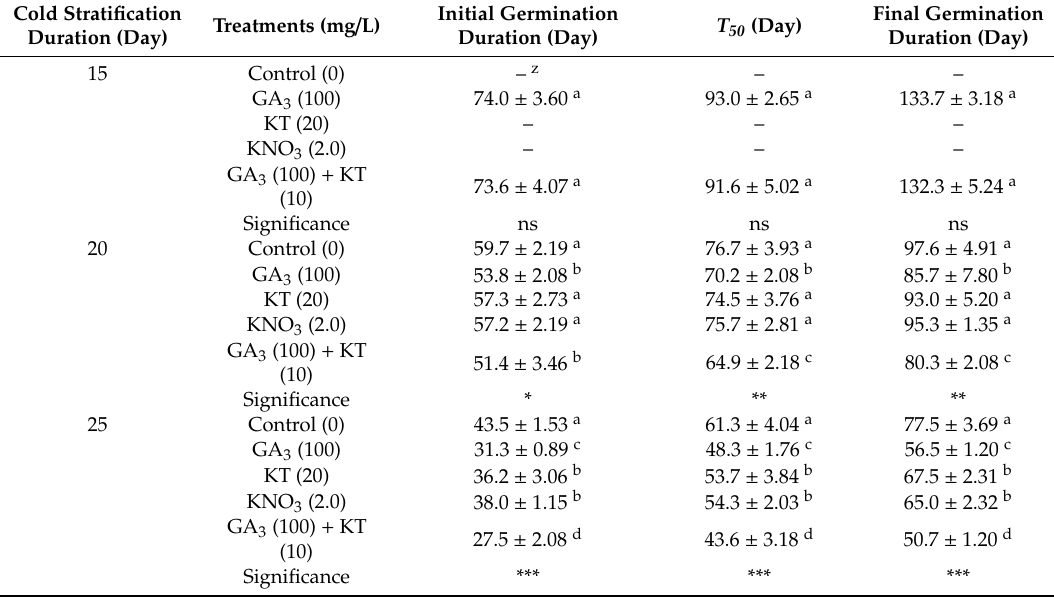
Table 4. Effect of the duration of stratification on Tulipa thianschanica seed germination at 4 °C with optimal concentrations of plant growth regulators.